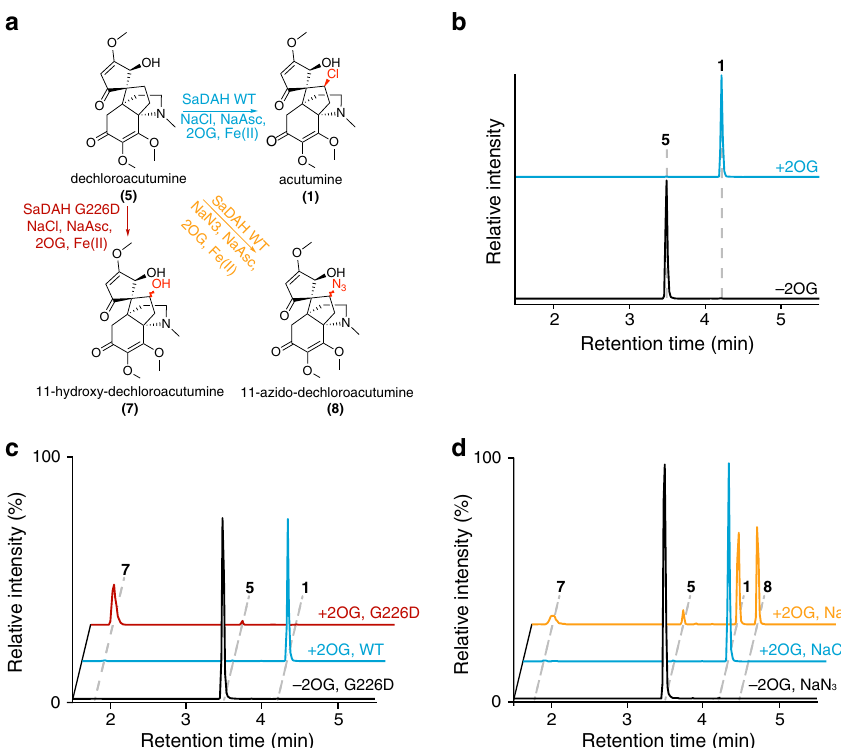
Fig. 2 Functional characterization of DAH and its G226D mutant by in vitro enzyme assays. a Alternative catalytic activities of SaDAH-WT and SaDAH- G226D. The chlorination, hydroxylation and azidation activities are colored in blue, red, and yellow, respectively. The putative regiochemistry of the − OH and − N 3 in 7 and 8 are highlighted in red, while the stereochemistry of the products remains undetermined. b XICs showing the in vitro activity of SaDAH- WT that chlorinates 5 to yield 1 in a 2OG-dependent manner. c XICs showing the in vitro activity of SaDAH-G226D that predominantly hydroxylates 5 – 7 in a 2OG-dependent manner. The chlorination product 1 is also produced as a minor product. d XICs showing the 2OG-dependent azidation activity of SaDAH-WT that converts 5 – 8 in reaction buffer containing 1 mM NaN 3 . The chlorination product 1 and the hydroxylation product 7 are also produced as side products. Mass windows used for displaying the XICs: 5 , 364.176 m/z ; 1 , 398.137 m/z ; 7 , 380.17 m/z ; and 8 , 405.18 m/z